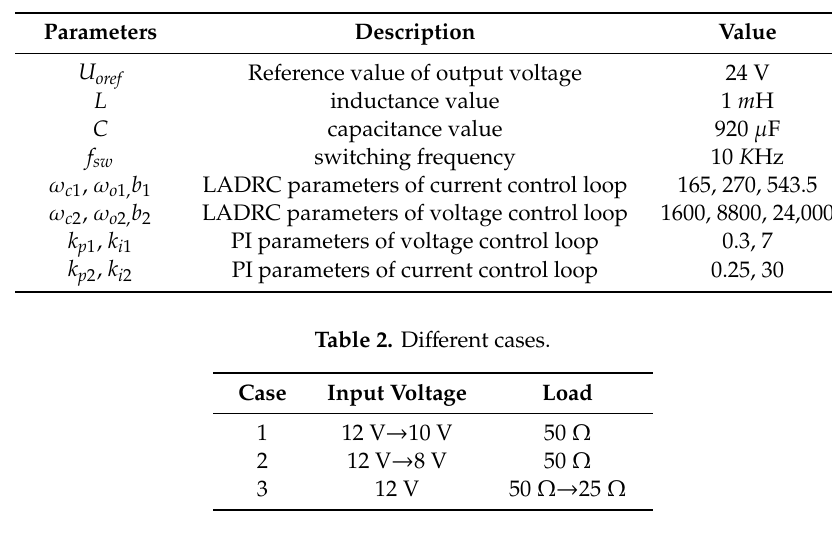
Figure 9. Inductance current responses in Case 1.